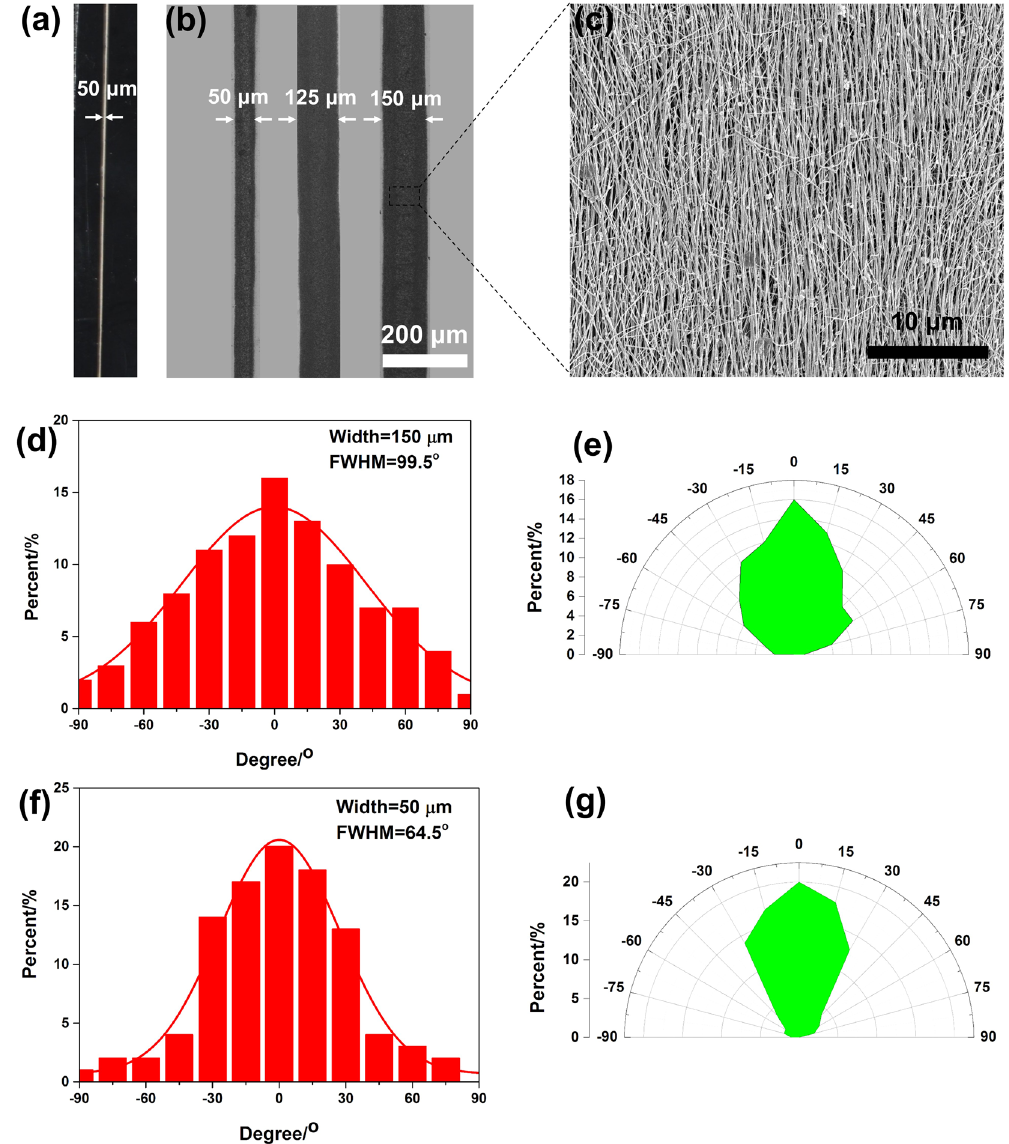
Figure 3. ( a ) Photograph of a printed AgNW line with length of 3 cm and width of 50 μ m. ( b ) Optical image of three AgNW lines with different line widths (50, 125 and 150 μ m) and the same spacing of 100 μ m. ( c ) Morphology of the printed AgNW line. ( d ) and ( e ) Histograms and polar diagrams of oriented angles of the gravure-printed AgNWs lines with 150 μ m line widths. ( f ) and ( g ) Histograms and polar diagrams of oriented angles of the gravure-printed AgNWs lines with 50 μ m line